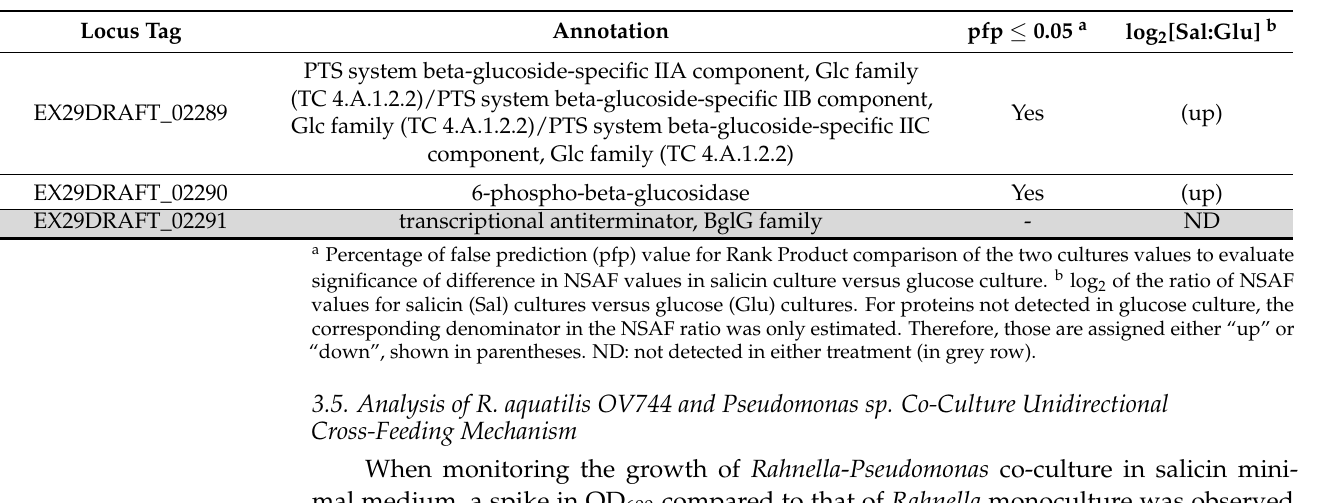
Table 2. Probable proteins involved in salicin degradation for R. aquatilis OV744 were detected in proteome of salicin cultures, but not in glucose